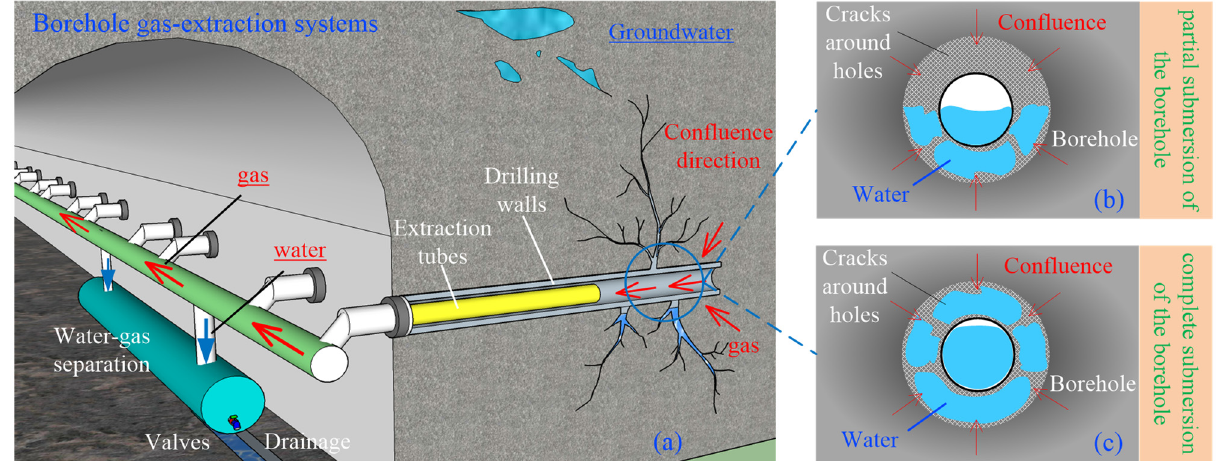
Figure 1. Schematic diagram of the effect of seam water on the permeability of the coal body around a gas extraction borehole. ( a ) Borehole gas extraction systems; ( b ) Partially submerged borehole; ( c ) Fully submerged borehole.